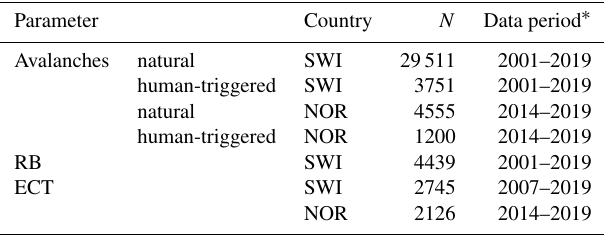
Table 1. Data overview.